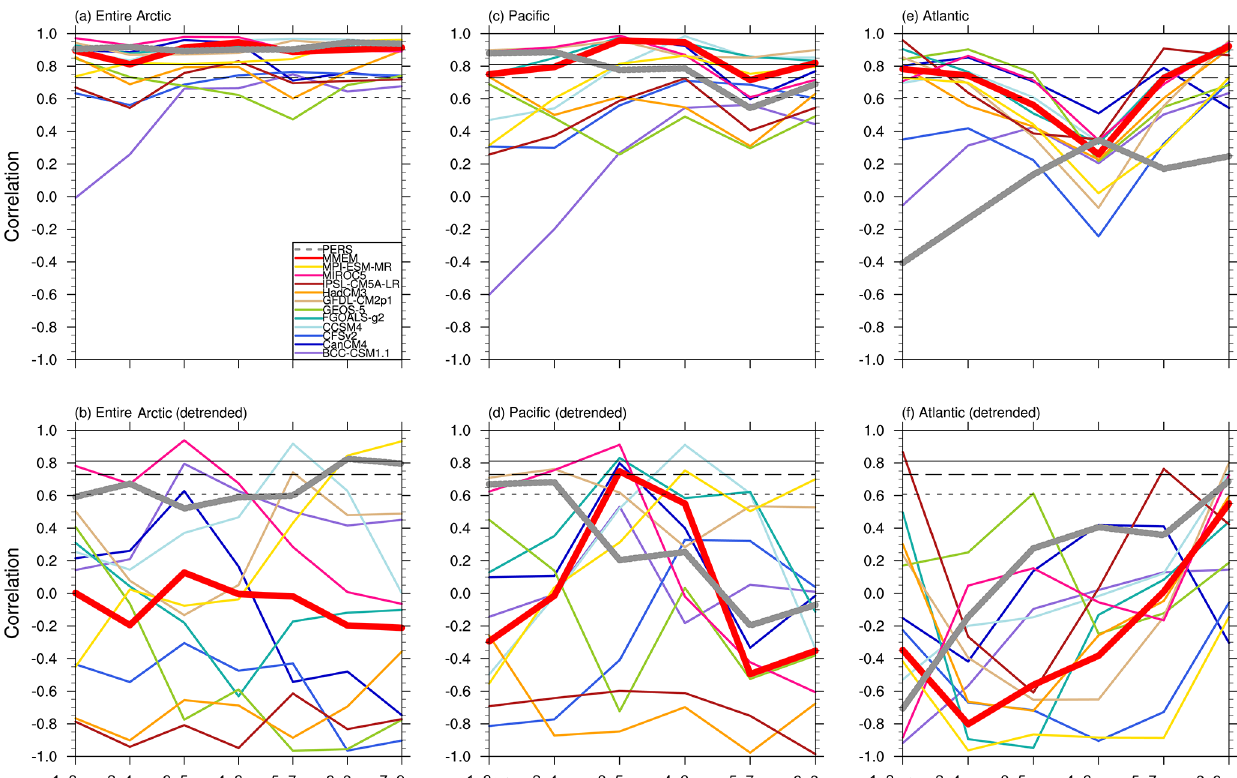
Figure 6. Anomaly correlation coefficients between the simulated and observed Arctic September sea ice extent anomalies for the three regional indices (the entire Arctic, Pacific, and Atlantic) as a function of the lead time. The top and bottom panels are the original and detrended time series, respectively. The horizontal dashed and solid lines represent 90, 95, and 99% confidence levels. The thick gray line is the persistence